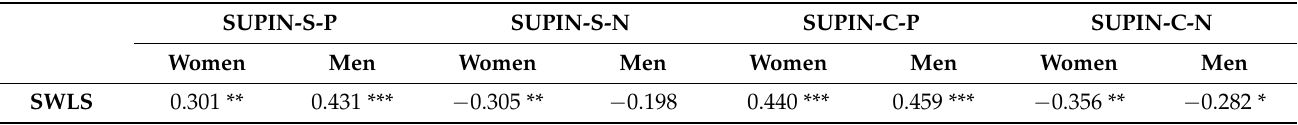
Table 12. Pearson’s r correlation coefficients between intensity of positive and negative emotions and life satisfaction at examined parents.